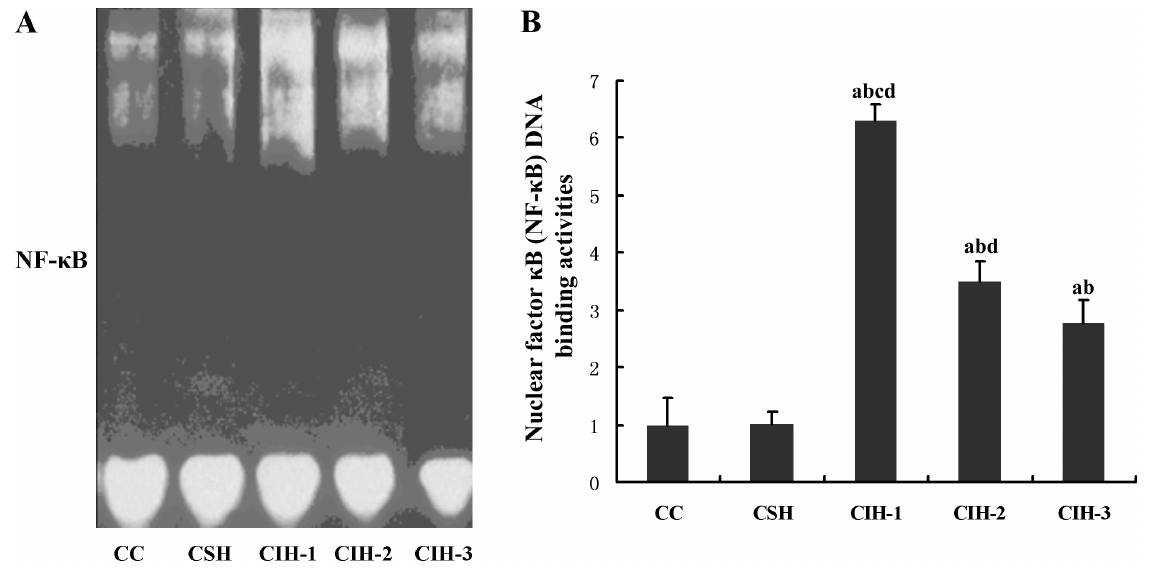
Figure 2. NF- k B DNA binding reaction of nuclear extract was performed with nonradiolabeled EMSA. a P , 0.05 compared with CC group; b P , 0.05 compared with CSH; c P , 0.05 compared with CIH-2,. d P , 0.05 compared with CIH-3.